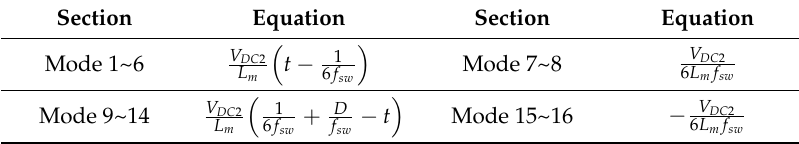
Table 4. Magnetizing inductor current equation of the phase A transformer depending on mode. Section